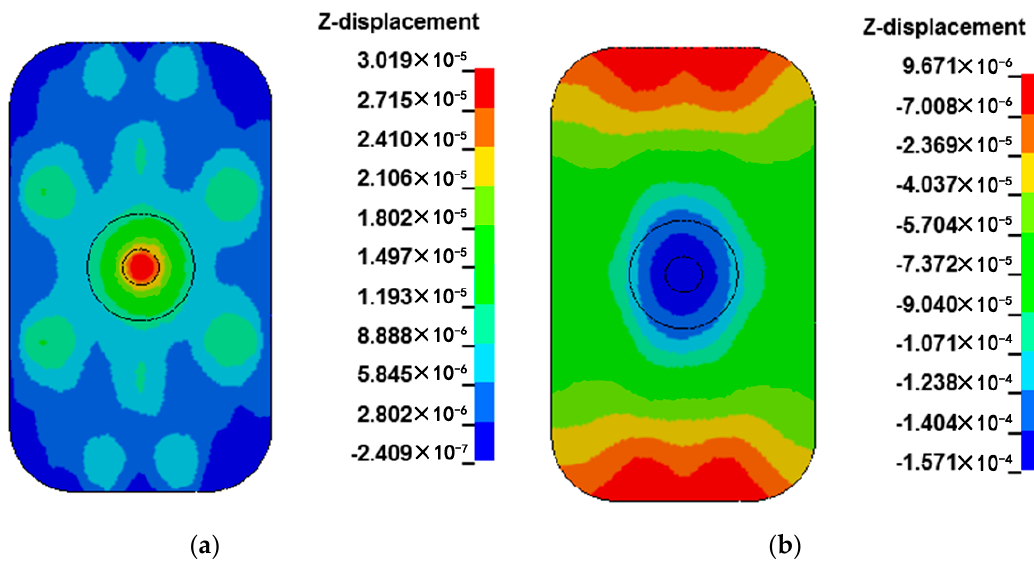
Figure 17. Deformation diagram under 50 Hz. ( a ) plate deformation distribution at the upper half cycle maximum. ( b ) plate deformation distribution at the lower half cycle maximum. The data for the mid-point of the short edge seam of the vertical column were extracted, and the displacement–time curve was drawn, as shown in Figure